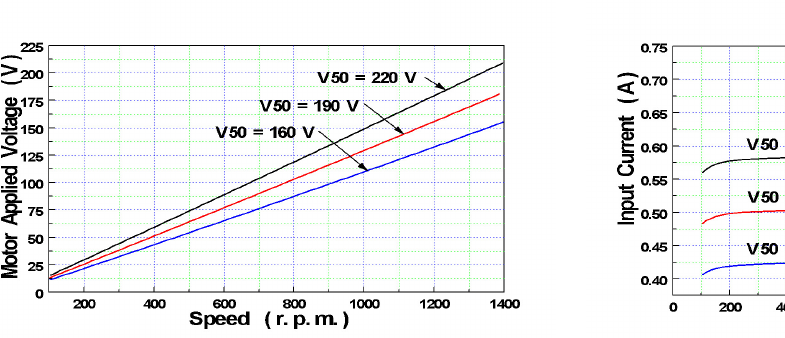
Fig. 5. Variation of input current with rotor speed